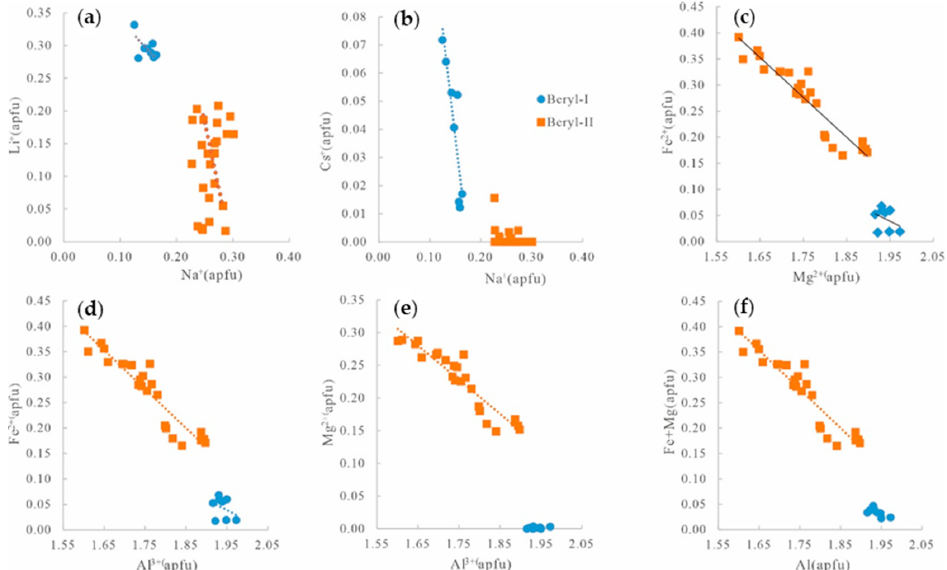
Figure 9. Plots of main cations in the X site, Y site and channel of beryl. (a): Li + vs. Na + plot. (b): Cs + vs. Na + plot. (c): Fe 2+ vs. Mg 2+ plot. (d): Fe 2+ vs. Al 3+ plot. (e): Mg 2+ vs. Al 3+ plot. (f): (Fe 2+ + Mg 2+ ) vs. Al 3+ plot. Fe is one of the most important chromogenic ions of beryl. In addition to replacing Al 3+ in the Y (octahedral) site, Fe appears in the channel, making it appear light green, blue–green, green–blue and light blue [56]. Emerald is chromatized by Fe, V and Cr [59], and a certain amount of Fe, V and Cr is detected in Beryl ‐ I and Beryl ‐ II. Thereby, there is likely to be a potential for further emerald prospecting at the Xianglin area.